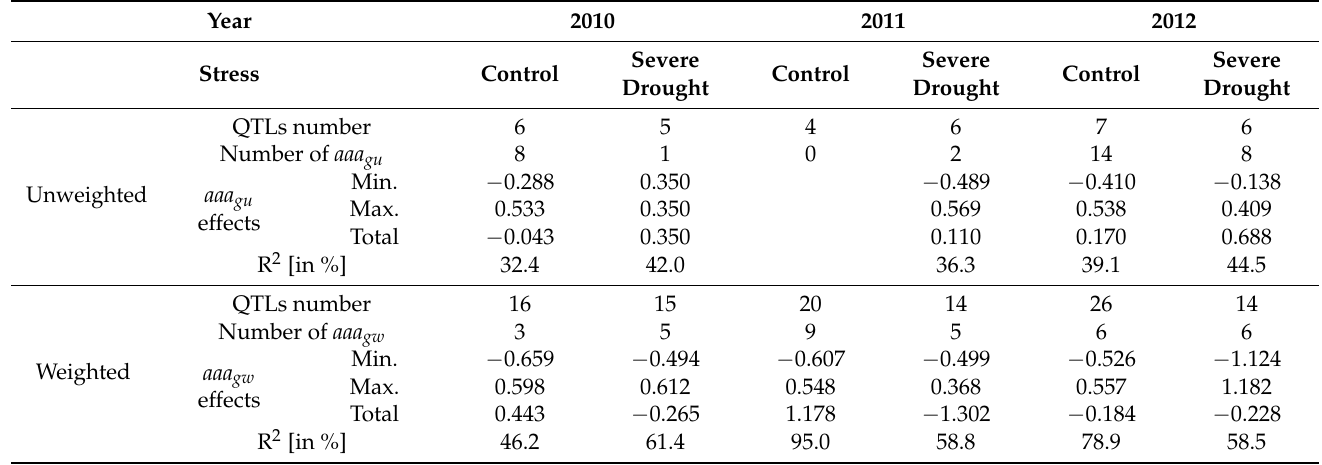
Table 2. Genotypic estimates of the total additive × additive × additive effects estimated based on unweighted ( aaa gu ) and weighted ( aaa gw ) multiple linear regression.